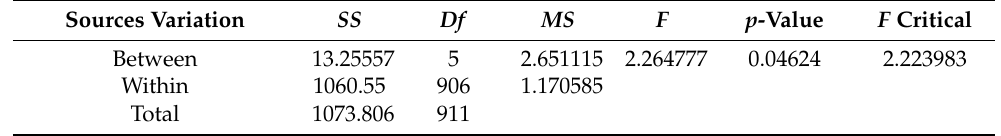
Table 5. ANOVA of effects of ICS on personal and professional growth. Sources